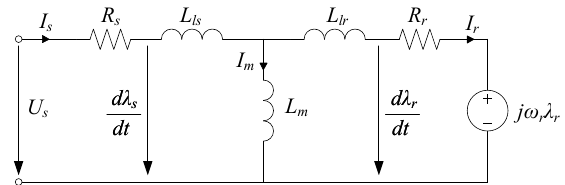
Figure 24. Dynamic induction motor